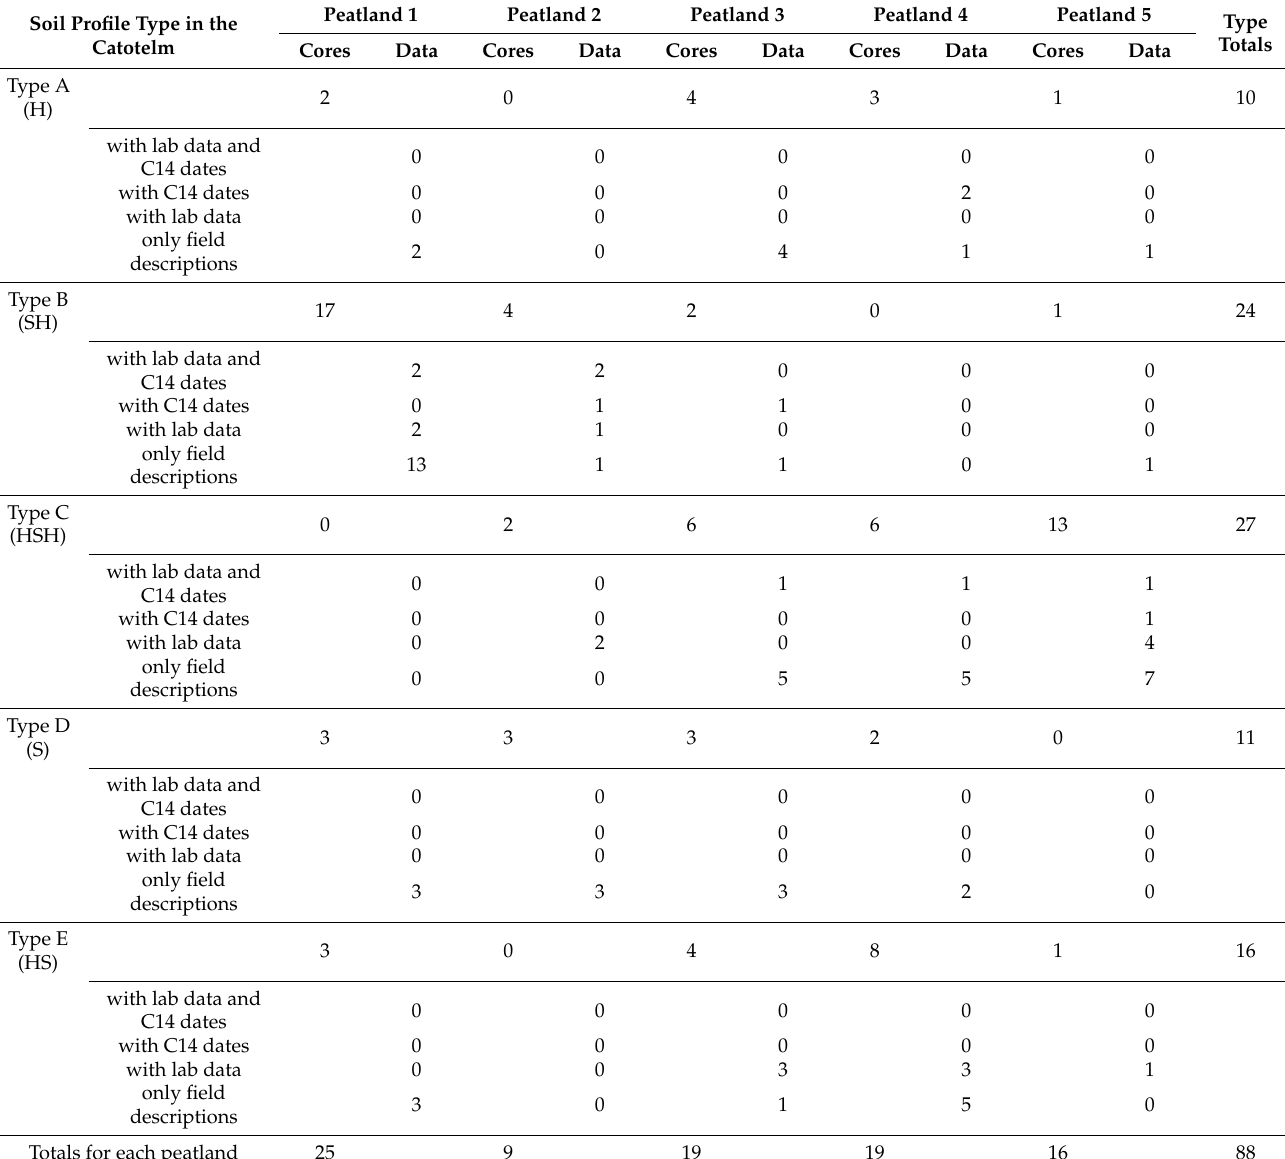
Table 2. Categorized catotelm profile type distribution amongst the five peatlands. S and H represent Sapric (highly decomposed) and Hemic (moderately decomposed). Type A has only Hemic horizons, Type B has Sapric over Hemic horizons, Type C has Hemic over Sapric over Hemic horizons, Type D has only Sapric horizons, and Type E has Hemic over Sapric